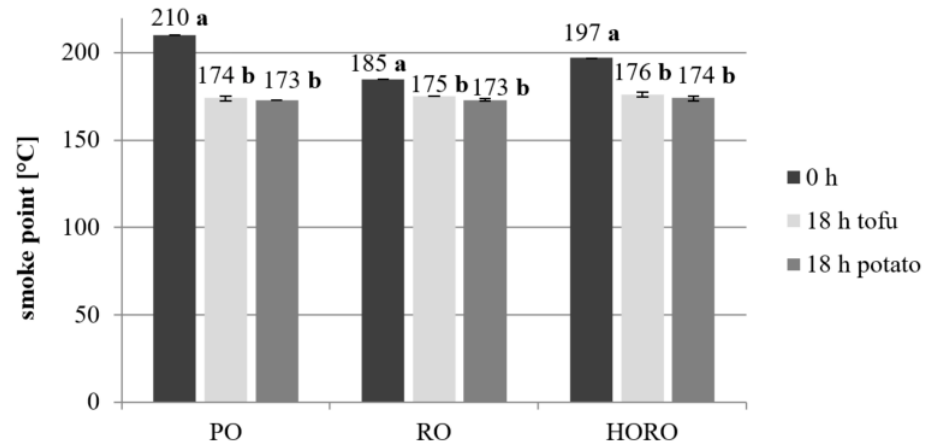
Figure 5. Changes in smoke point [°C] of tested oils after frying of tofu or potatoes. PO—palm olein; RO—cold pressed rapeseed oil; HORO—cold pressed high oleic rapeseed oil. The values for the specific oil and type of fried product with different letters (a, b) are significantly different ( p < 0.05).